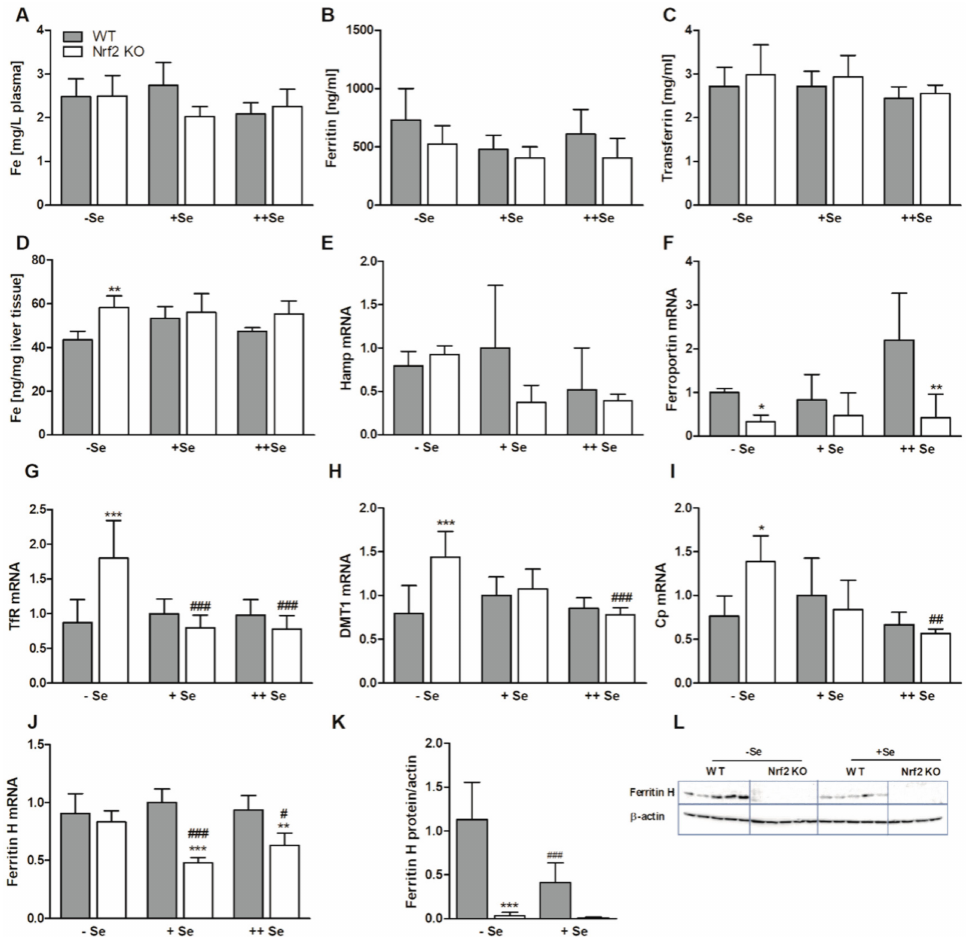
Figure 4. Biomarkers of the Fe status. Fe ( A ), ferritin ( B ), and transferrin ( C ) concentrations in the plasma of male Nrf2 KO and WT mice fed diets with defined Se contents (–Se: 0.03 ppm; + Se: 0.15 ppm; ++ Se: 0.6 ppm). Additionally, Fe concentration in the liver ( D ) as well as mRNA and protein expression of Fe-related genes / proteins in the liver were determined by qPCR or western blot, respectively ( E , G – L ). Ferroportin mRNA was measured in the duodenum ( F ). The TE profile was analyzed using ICP-MS / MS ( A , D ). Further Fe plasma parameters were detected by ELISA ( B , C ). Bars represent means + SD ( n = 4–5). * p < 0.05; ** p < 0.01; *** p < 0.001 vs. WT and # p < 0.05; ## p < 0.01; ### p < 0.001 vs. –Se